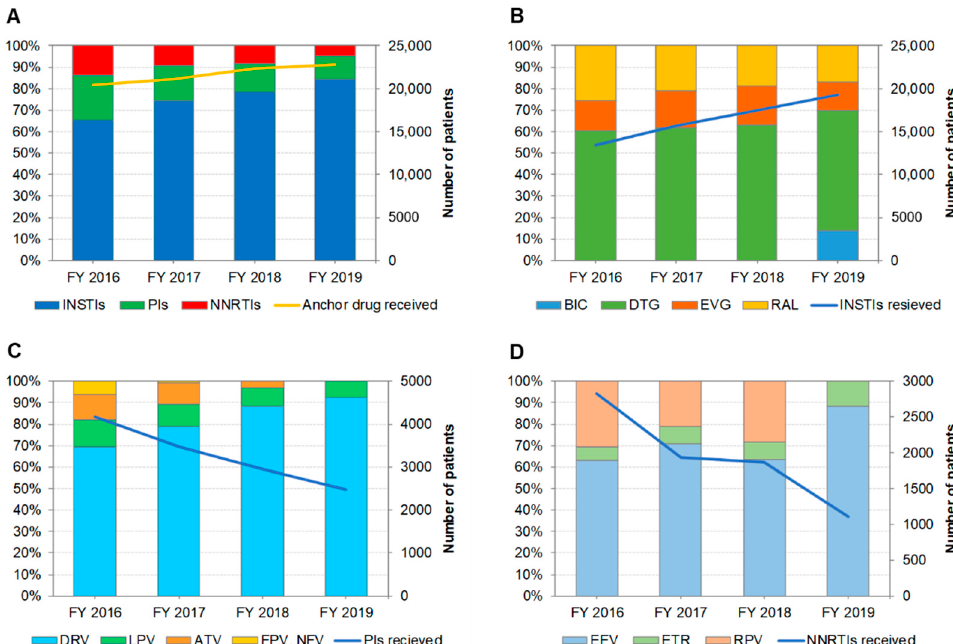
Figure 2. Changes in anchor drug prescriptions from FY 2016 to FY 2019. ( A ) Changes in prescrip- tion of class (mechanism of action) selected as anchor drug, ( B ) changes in prescription of individual INSTI drugs, ( C ) changes in prescription of individual PI drugs, ( D ) changes in prescription of individual NNRTIs drugs. The analysis was performed on drugs listed in Table 1. INSTI: integrase strand transfer inhibitor, NRTI: nucleoside reverse transcriptase inhibitor, NNRTI: non-nucleoside reverse transcriptase inhibitor, PI: protease inhibitor, BIC: bictegravir, DTG: dolutegravir, EVG: elvitegravir, RAL: raltegravir, DRV: darunavir, LPV: lopinavir, ATV: atazanavir, FPV: fosamprenavir, NFV: nelfinavir, EFV: efavirenz, ETR: etravirine, RPV: rilpivirine.